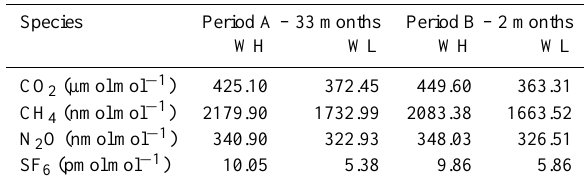
Table 3. Trace gas mole fractions of GC working standards used during period A (July 2010 to April 2013) and period B (May